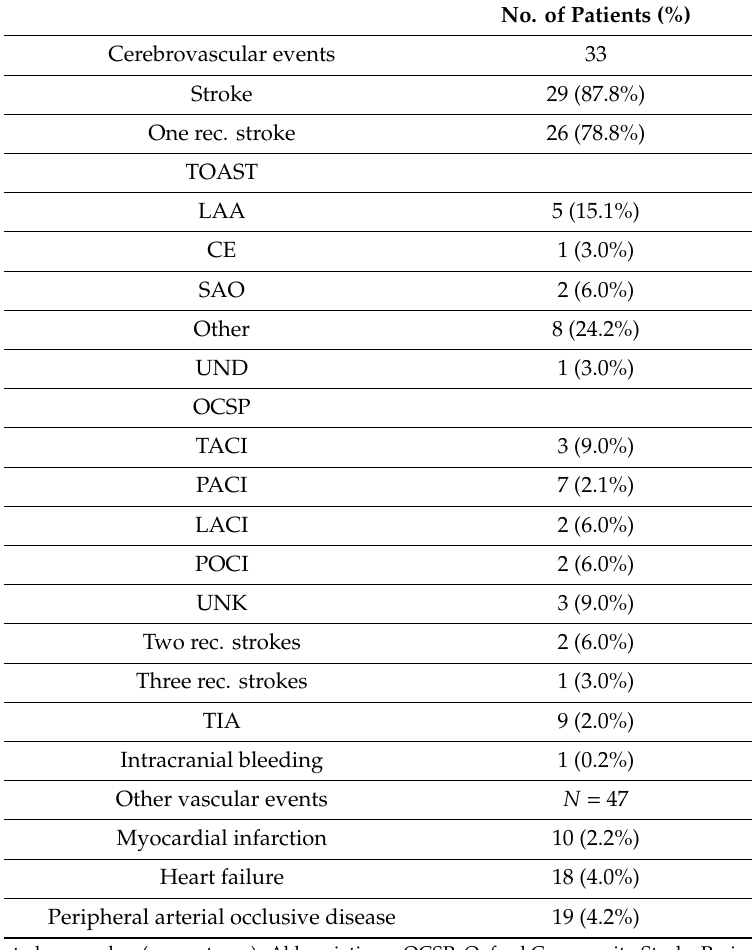
Table 2. Clinical events after 7 years of